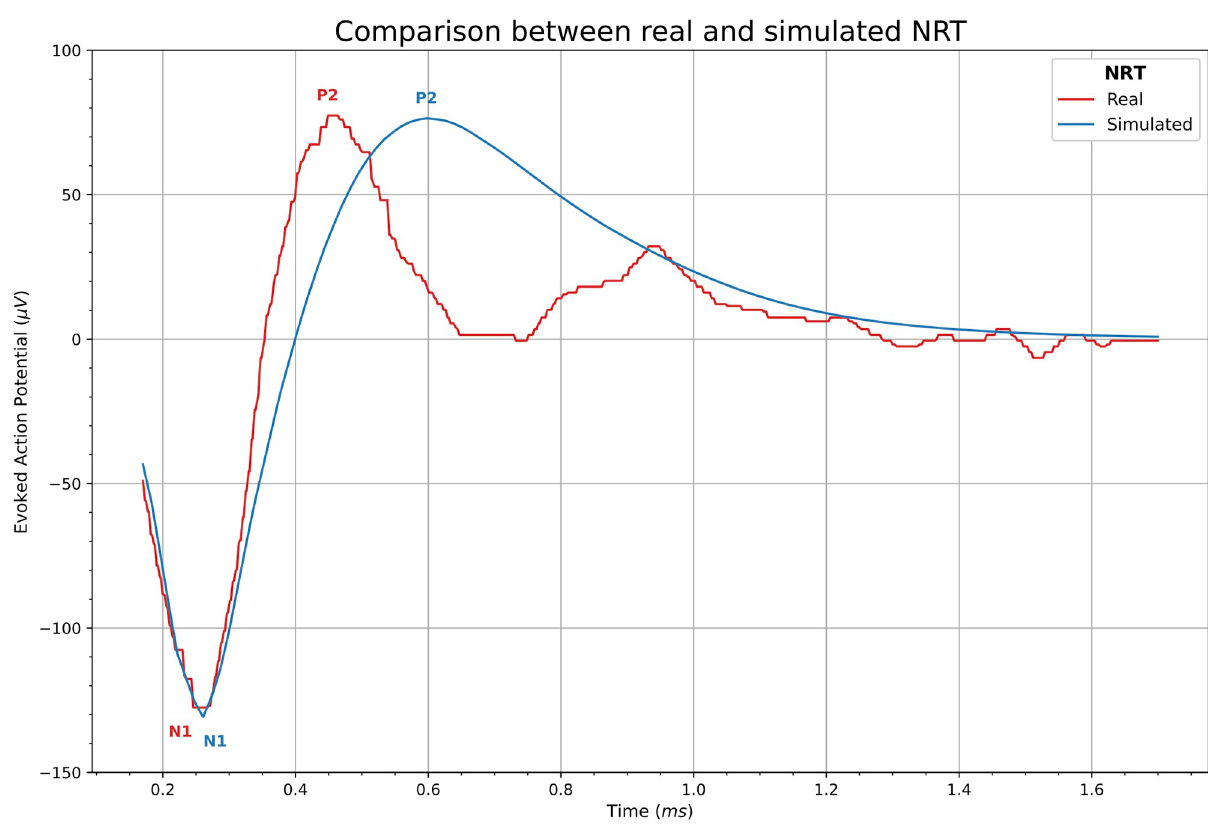
Fig 12. Comparison between real and simulated NRT. Real NRT from patient 1 and stimulating electrode 6 with the intensity I 3 = 1.02 mA and recorded at electrode +2 (red). Computed NRT fitted to the patient data (blue).